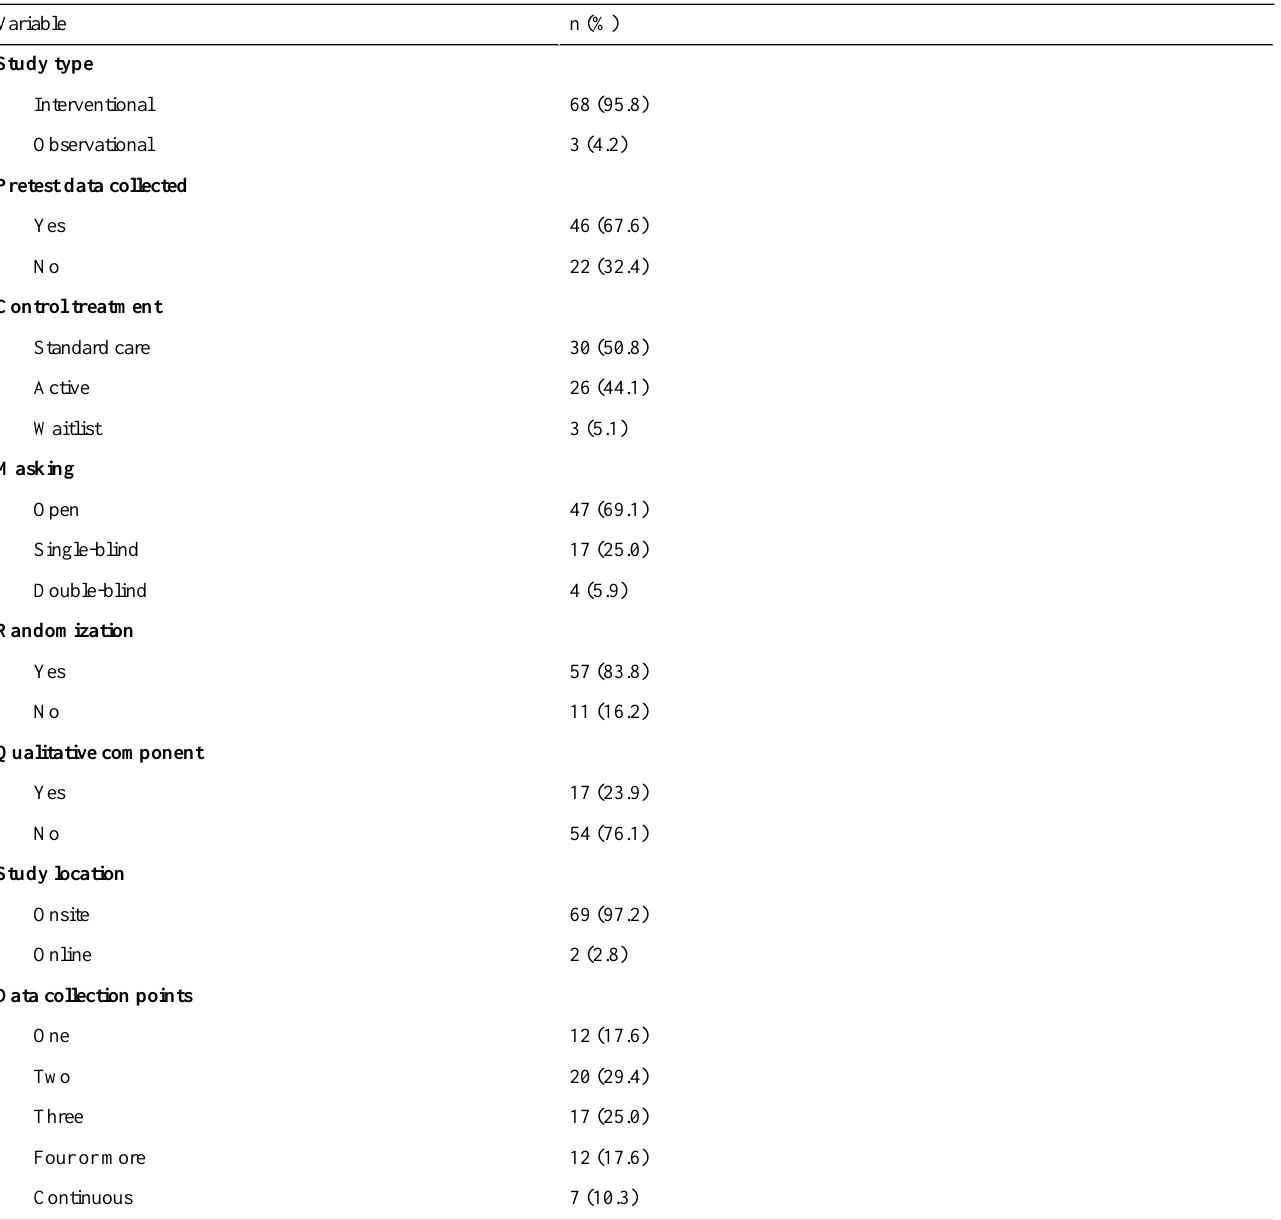
Table 4. Distribution of apps across methodological